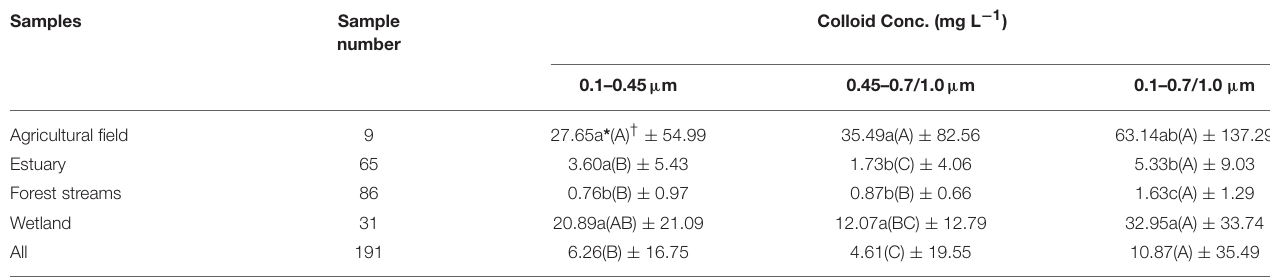
TABLE 1 | Colloid concentrations in 0.1–0.45, 0.45–0.7/1.0, and 0.1–0.7/1.0 µ m size fractions in samples from different sites.